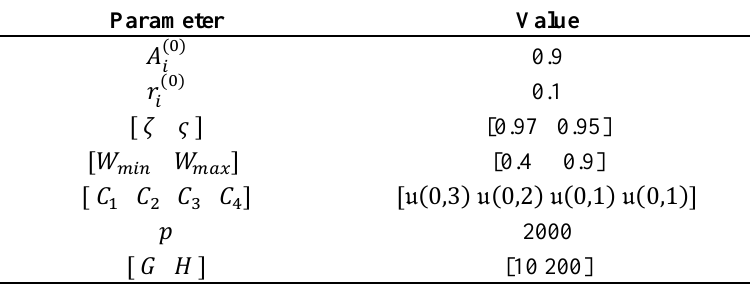
Table 3. Optimization